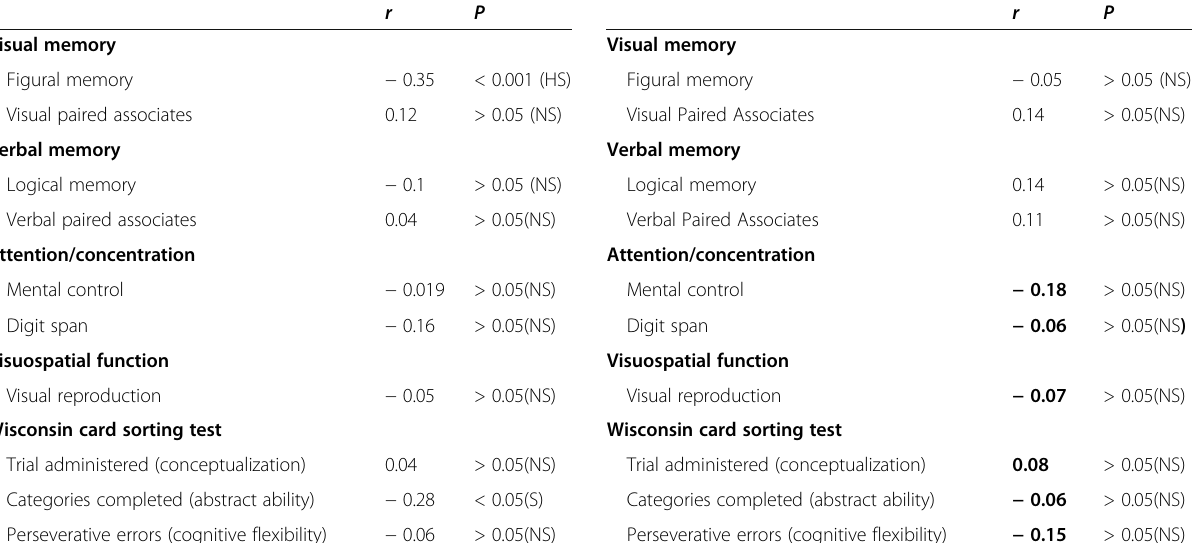
Table 5 Correlation between duration of illness and cognitive and executive functions